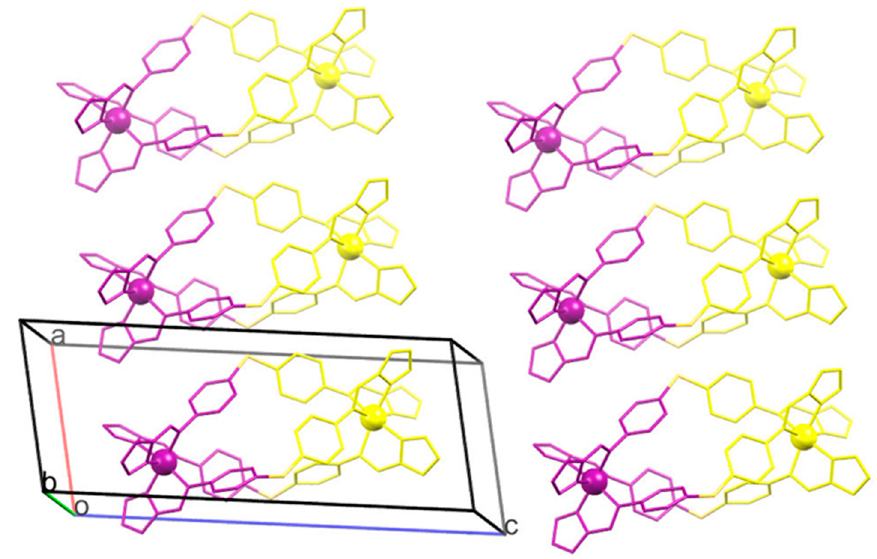
Figure 5. Schematic representation of the X-ray crystal structure of 2 at 100 K showing the distribution of high (yellow) and low spin (purple) Fe(II) centres along the crystallographic c - and a -axis. Hydrogens, solvent and counter ions have been excluded for clarity.